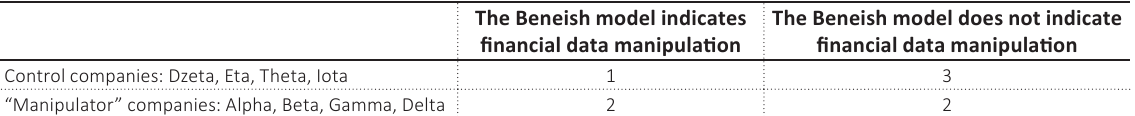
Table 6. Number of indications of the Beneish 5-factor model for “manipulator” and “non-manipulator” companies